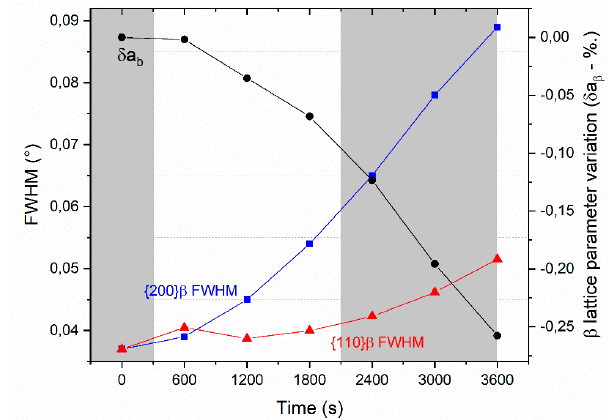
Figure 8. Influence of ageing time on the FWHM of {110} β and {200} β peaks and on the variation of a β ( δ a β ).